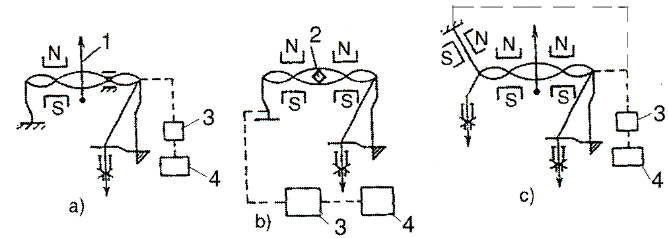
Figure 3. Double helicoidal multivibrators with ( a ) the pointer-arrow 1 on the string; ( b ) mirror-pointer 2 on the string; ( c ) differential type of helicoid-cable version [1], self oscillator3, and frequency meter 4 (reprint from [1], presented with the Springer